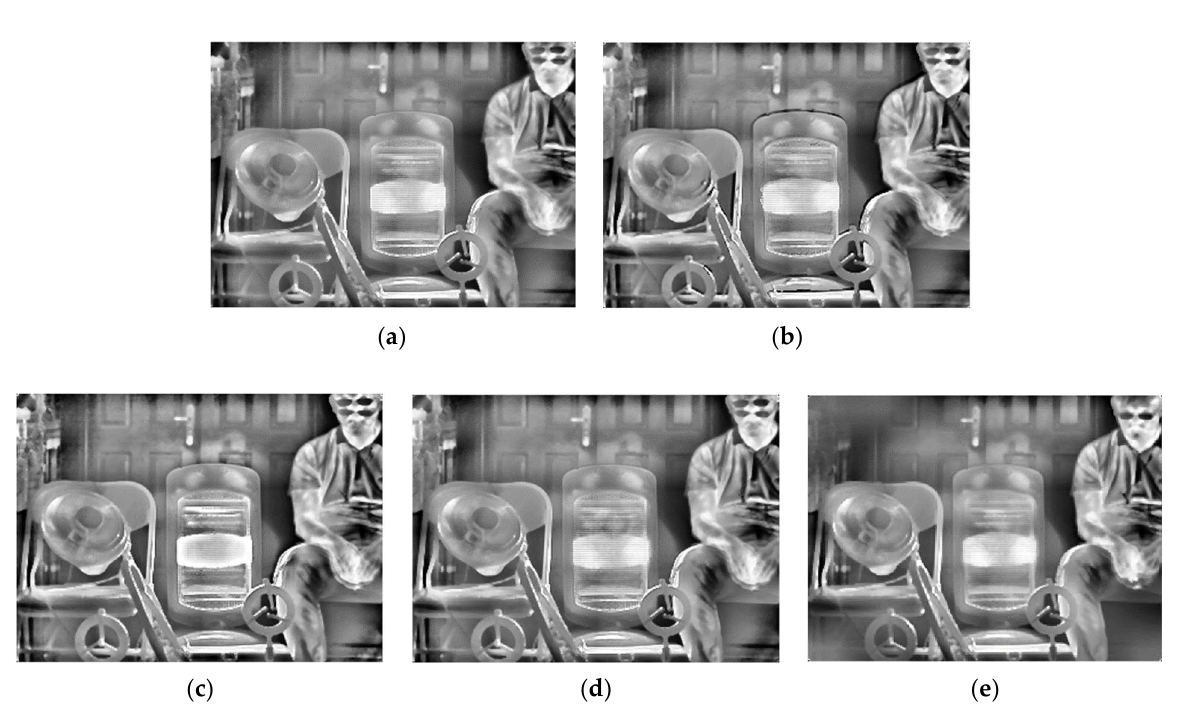
Figure 17. Fusion results of five typical fusion methods for scene 2: ( a ) Mertens; ( b ) Vonikakis; ( c ) Ma; ( d ) Kou; ( e ) MIF&DE.